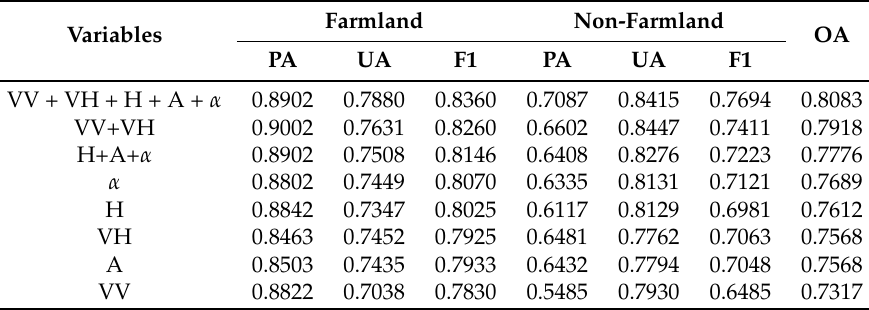
Table 5. Classification performance using different